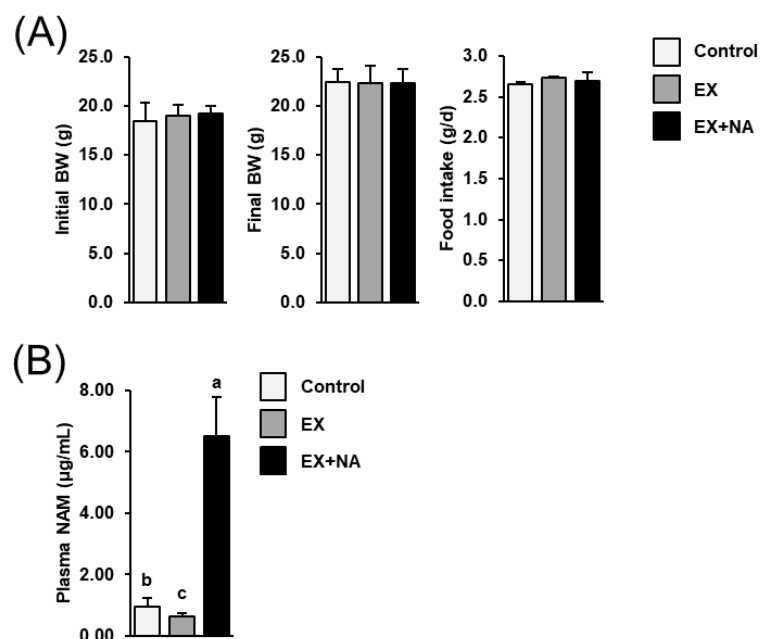
Figure 1. Initial and final body weights (BW) and food intake ( A ) and plasma nicotineamide (NAM) concentration ( B ) of sedentary mice fed an NA (nicotinic acid) adequate diet (Control) and mice subjected to regular endurance exercise fed either an NA adequate diet (EX) or a high NA diet (EX + NA) for 6 weeks. Bars represent means ± SD for n = 10 animals per group. Bars without a common lowercase letter (a, b, c) differ, P < 0.05.